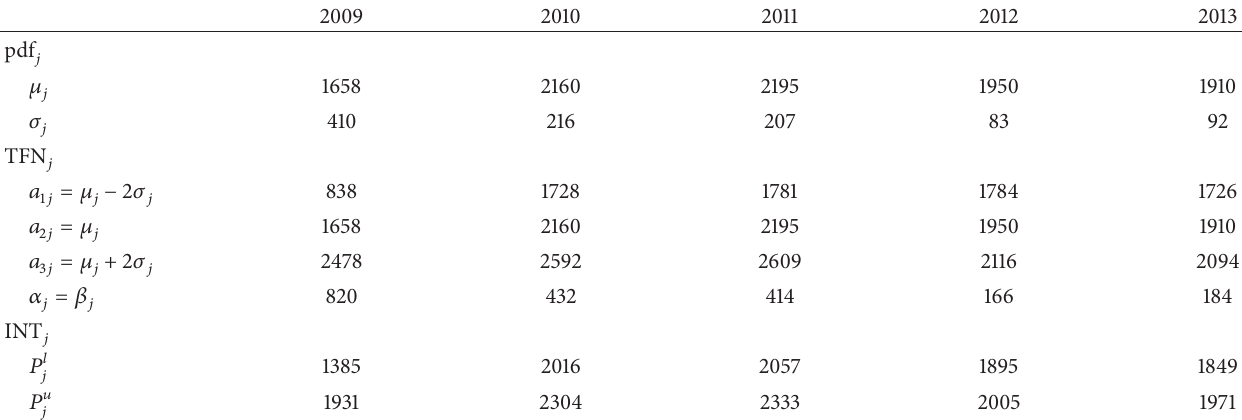
Table 2: Transformation pdf 𝑗 → TFN 𝑗 → INT 𝑗